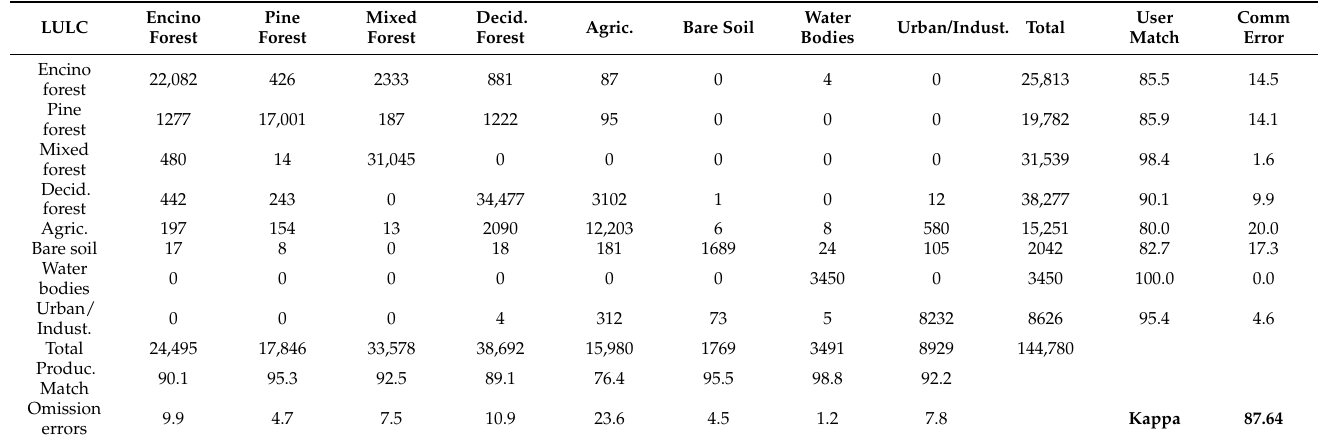
Table 2. Confusion matrix of the final base date LULC map compared with the ground-truth reserved for the validation stage. LULC Encino Forest Pine Forest